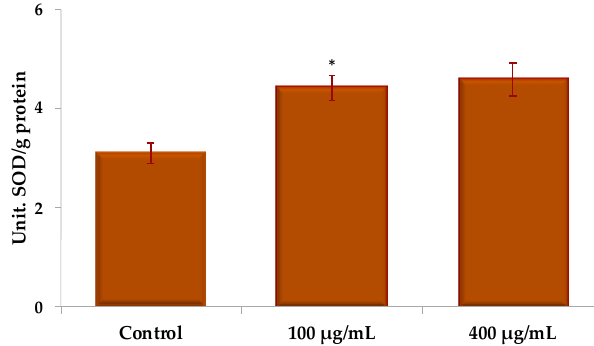
Figure 8. Evaluation of SOD activity (U SOD/g protein) under action of different UBE concentrations on CAL 27 cells. The results represent the mean ± SE of three independent experiments (* p < 0.05) when comparing the effects of UBE with the untreated control (t-test).